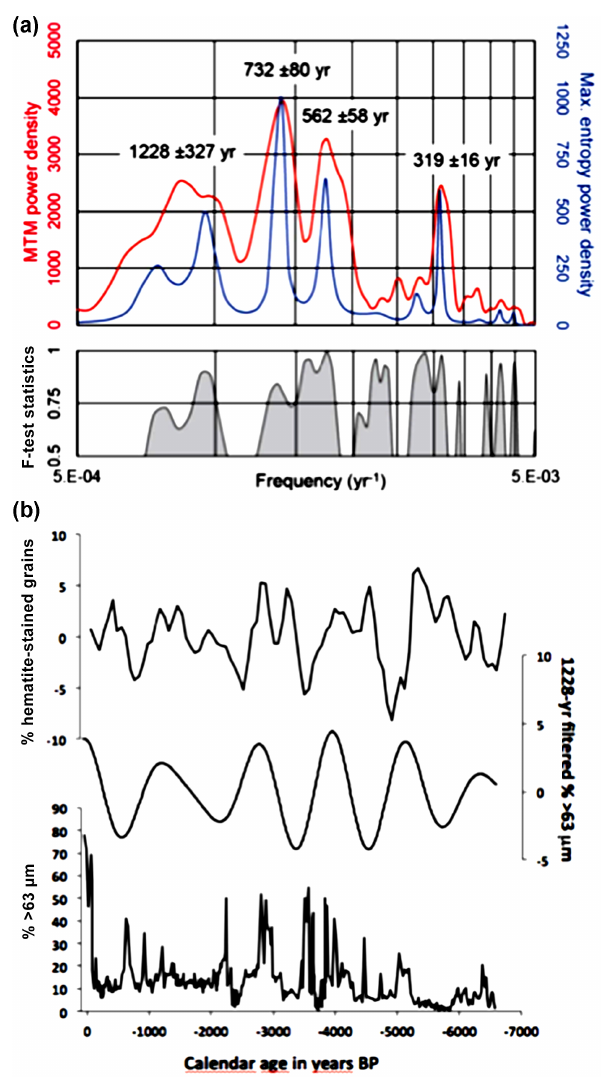
Figure 9. Time series analysis from the Mar Menor MM2 record. Panel (a) : spectral analyses of the percentage of sand with Analy- Series v.2.0.8 (Paillard et al., 1996) by using the multi-taper method (linear trend removed; width.ndata product: 1.3; number of win- dows: 2) and the maximum entropy method (linear trend removed; percentage of series: 40, number of lags: 133). Panel (b) : compari- son between the percentage of hematite-stained grains (Bond et al., 1997, 2001), the Gaussian filter on the percentage of sand for the 1228-year period (frequency: 0.0008; bandwidth: 0.0002) and the sand fraction of the core